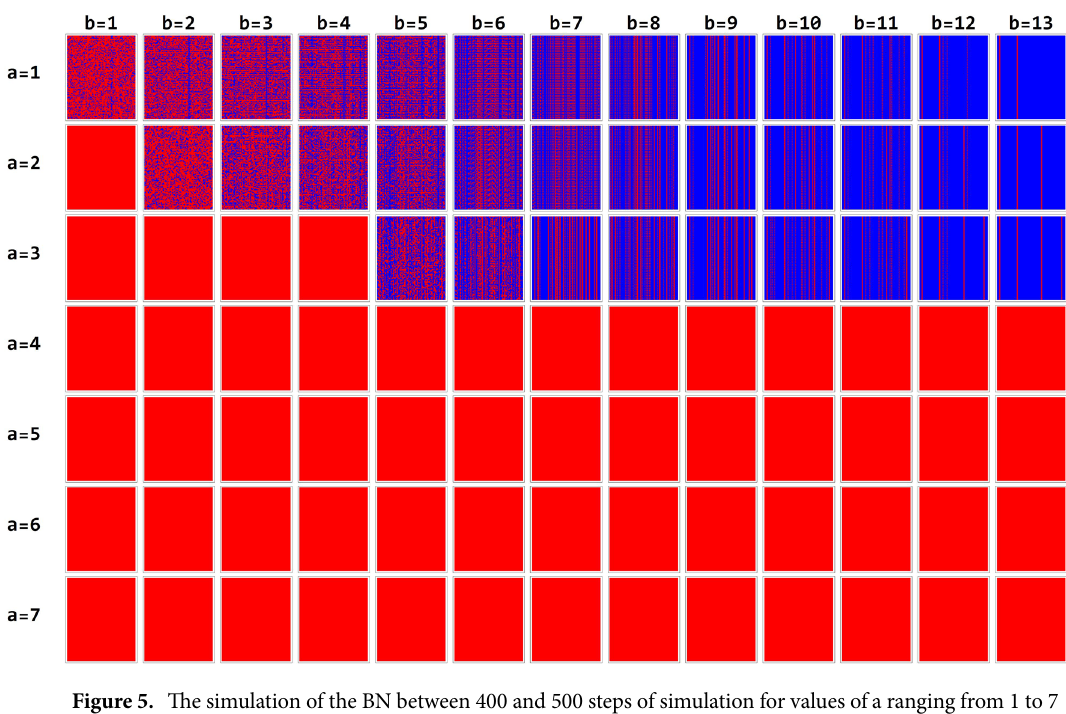
Figure 5. The simulation of the BN between 400 and 500 steps of simulation for values of a ranging from 1 to 7 and values of b ranging from 1 to